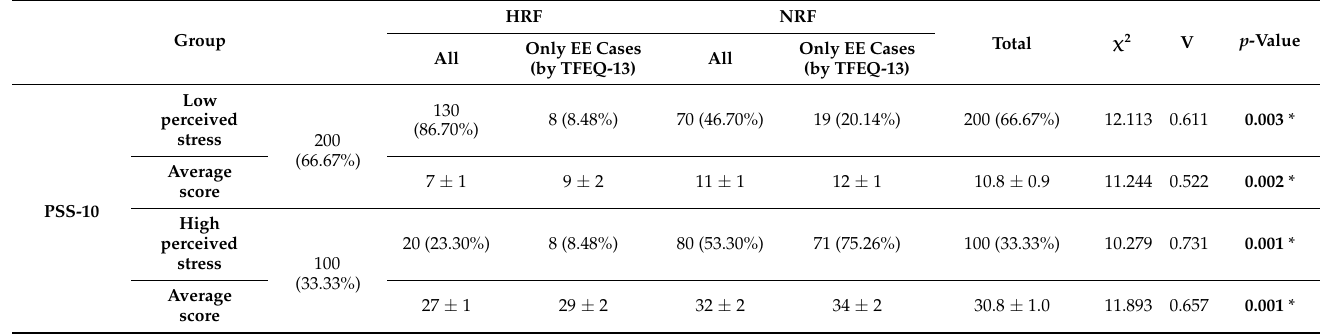
Table 2. Comparison of PSS-10 and TFEQ-13 scores in the study group (N = 300; HRF = 150; NRF =